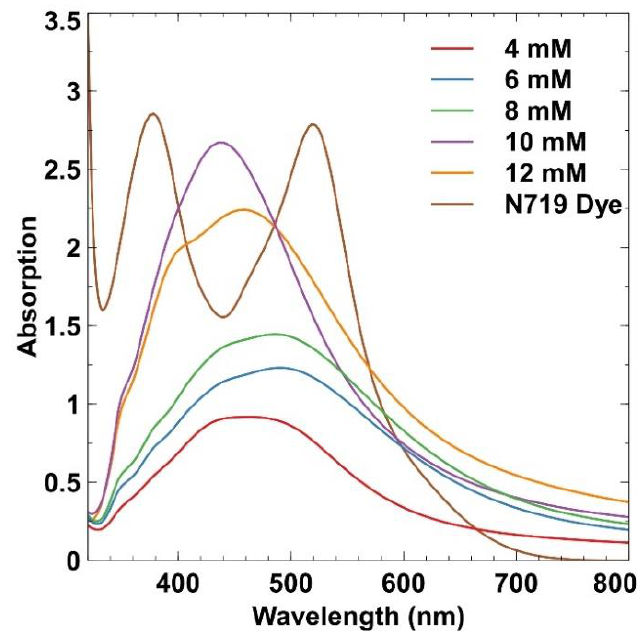
Figure 4. Ultraviolet – visible (UV – Vis) absorption spectrum for N719 dye and different concentration of sodium citrate measured using UV-Vis spectrophotometer.